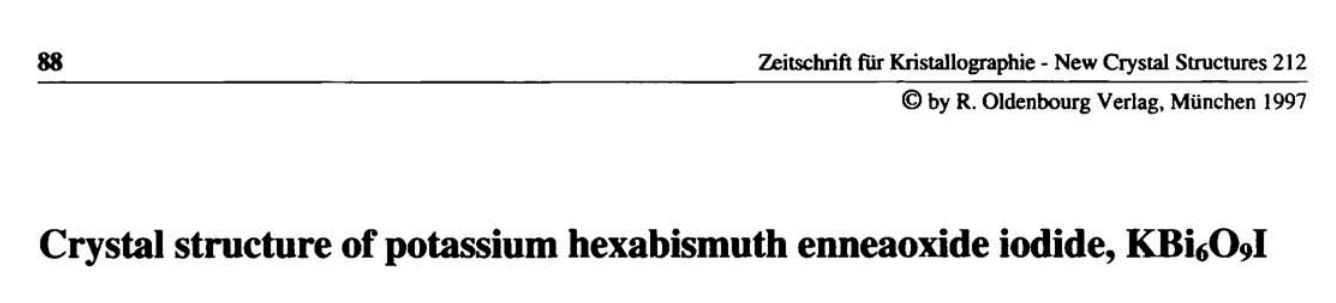
Source of material: Small single crystals of KB16O9I grew after drop by drop addition of a 0.005n solution of B1I3 in 3n HI to 10η KOH. The K, Bi and I atoms form a distorted bcc-like substructure. The Κ, I substructure consists of non-intersecting infinite linear chains parallel to <111>. The coordination polyhedra of Bi are similar to those ones found in ß-Bis07l (see ref. 1). BÍ6IKO9, cubic, Ia3d (No. 230), a =17.254(3) Â, V =5136.5 Â 3 ,